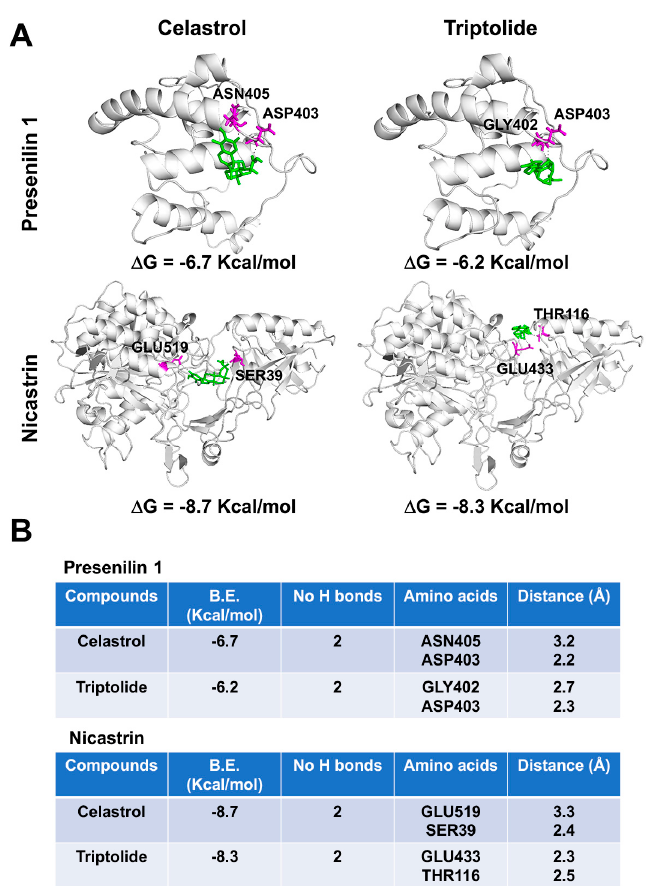
Figure 5. Celastrol and Triptolide bind to γ -secretase proteins presenilin 1 and nicastrin. ( A ) Binding of Celastrol and Triptolide in the protein cavity of presenilin 1 and nicastrin were assessed by molecular docking technique using Autodock vina software program. Celastrol and Triptolide bind to presenilin 1 and nicastrin with the binding energy (B.E.) of − 6.7 and − 7.2 Kcal/mol respectively, as well as bind to nicastrin with B.E. of − 8.7 and − 8.3 Kcal/mol respectively. Cartoon models are represented in the figure. ( B ) The docking results and consensus scores of Celastrol and Triptolide binding to presenilin 1 and nicastrin are summarized.